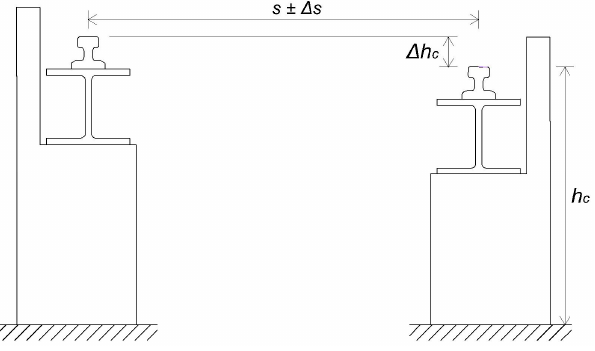
Figure 1. Span tolerance and height difference between the rails [17].